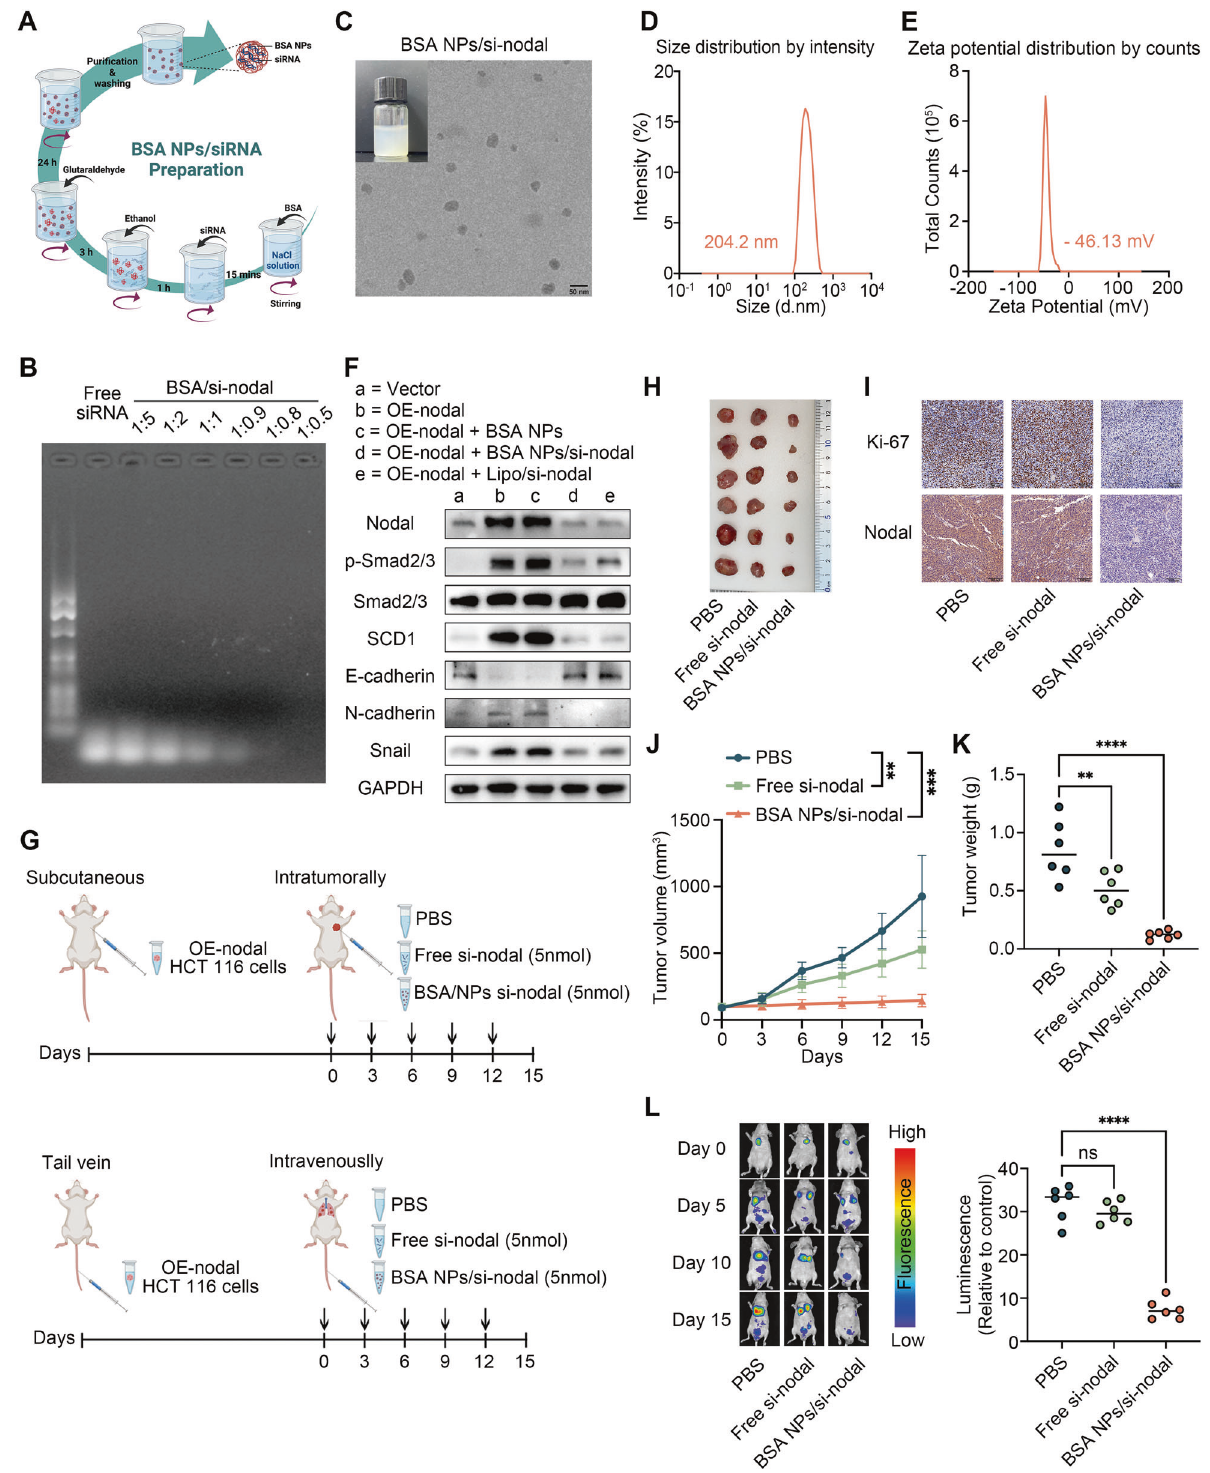
Fig. 7 BSA-NP/si-Nodal nanocomplexes inhibit the proliferation and metastasis of CRC. A Schematic diagram for the preparation of BSA- NP/si-Nodal nanocomplexes. B Agarose gel retardation assay was performed to evaluate the encapsulation ef fi ciency of BSA-NPs. C Transmission electron microscopic images of BSA-NP/si-Nodal nanocomplexes. D , E The hydrodynamic particle size and zeta potential distribution of BSA-NP/si-Nodal complexes were measured via dynamic light scattering. F Western blot analysis of Nodal, SCD1, Smad2/3, p-Smad2/3, E-cadherin, N-cadherin and snail expressions in cells with different treatments. G Schematic diagram of in vivo experiments in tumour-bearing mice models. H – J Tumour images, tumour volume and tumour weight in mice. K IHC analysis of the Ki67 and Nodal expressions. L Fluorescence images and fl uorescence intensity analysis of nude mice with lung metastasis ( ∗∗ P < 0.01 and ∗∗∗ P < 0.001).